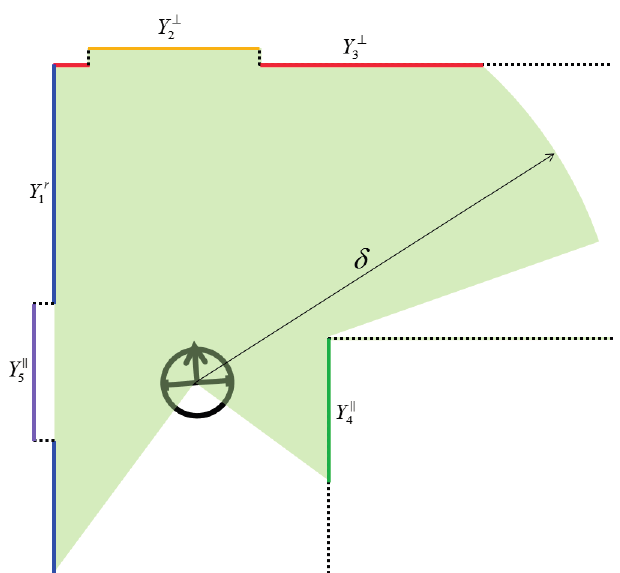
Figure 3. Constrained relations of extracted line